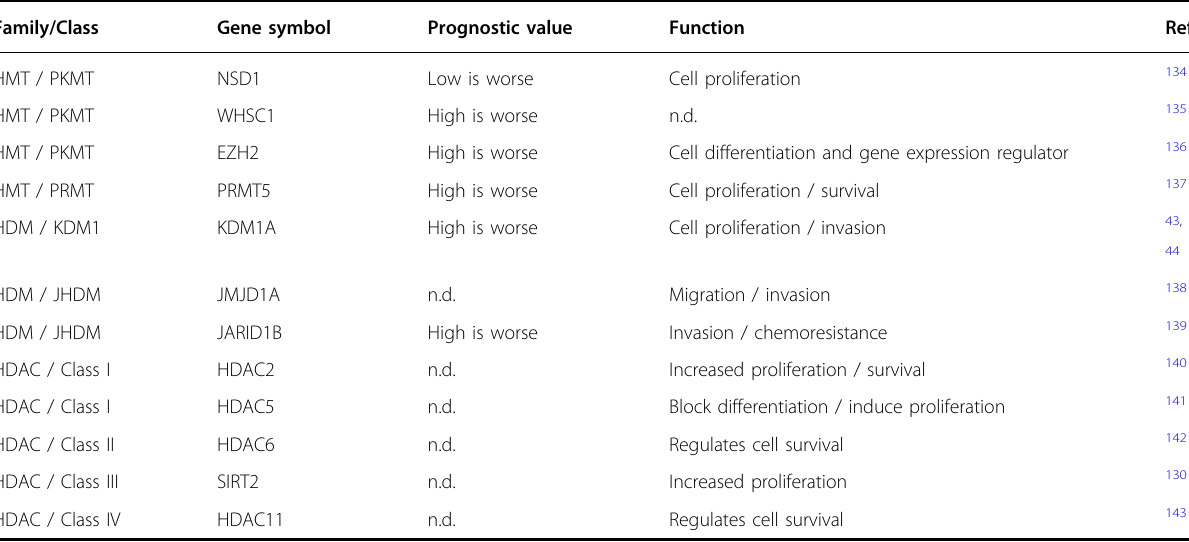
Table 3 Potential new epigenetic targets in neuroblastoma at early preclinical research studies